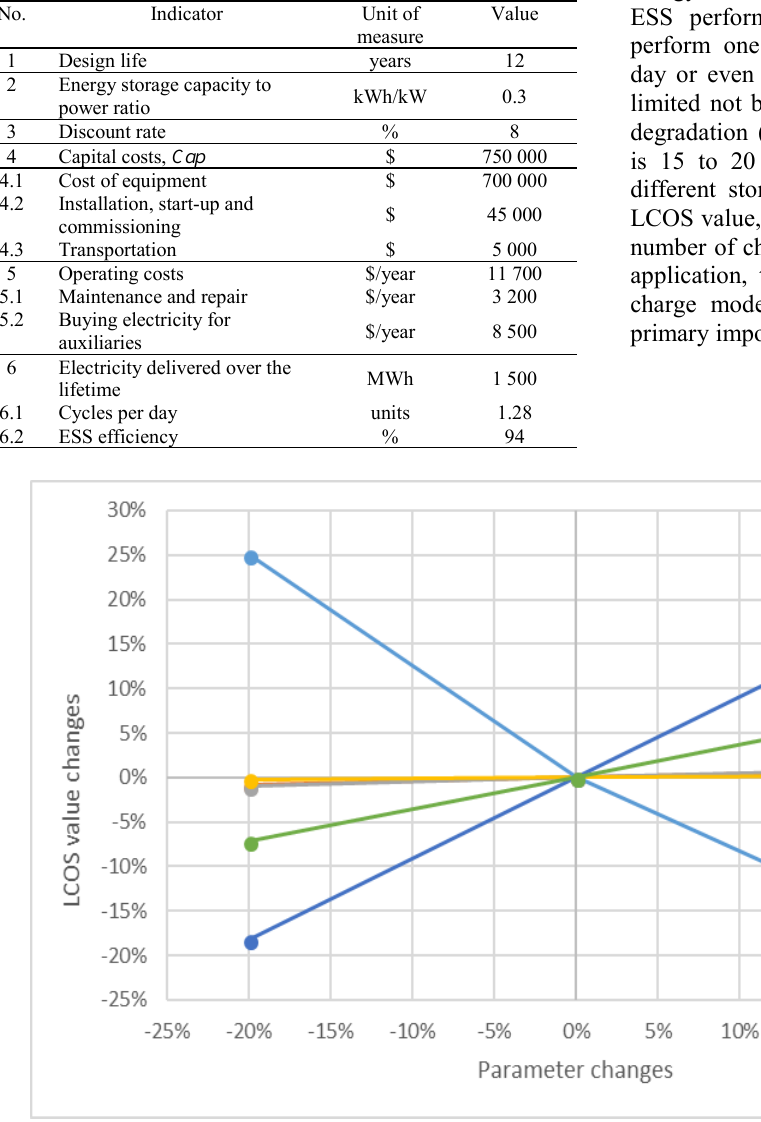
Table 1. Input data for the LCOS calculation